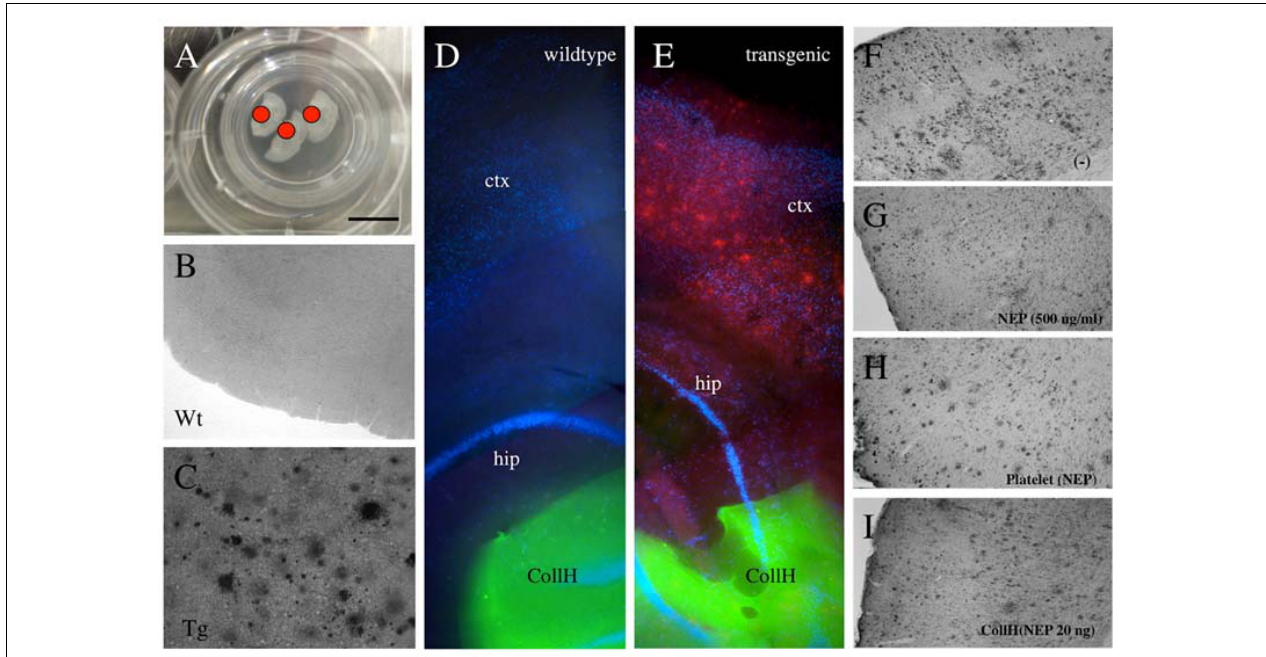
FIGURE 2 | Application of collagen- hydrogels on organotypic brain slices. Organotypic brain slices (110 µ m thick, 3 brains per well) were prepared and cultured on semipermeable membranes (A) and hydrogels were applied directly onto the brain slice [red dot in (A) and green fluorescent in (D,E) ]. Collagen hydrogels were applied onto 9 month old wildtype mice brain slices (B,D) or slices from transgenic APP_SweDI mice with plaques (C,E) . No plaques are seen by immunostainings in wildtype mice (B,D) , while in transgenic mice many small and large (C,E,F) plaques are visible. Neprilysin [500 ng/ml in medium; (G) ], loaded into platelets (H) or loaded into hydrogels (I) reduced the plaque number, compared to a negative control (F) . Scale bar in A = 7.5 mm (A) , 200 µ m (B,C) , 500 µ m (D,E) , 400 µ m (F–I) . ctx, cortex; hip, hippocampus; Wt, wildtype; Tg, transgenic; CollH, collagen hydrogels; NEP,